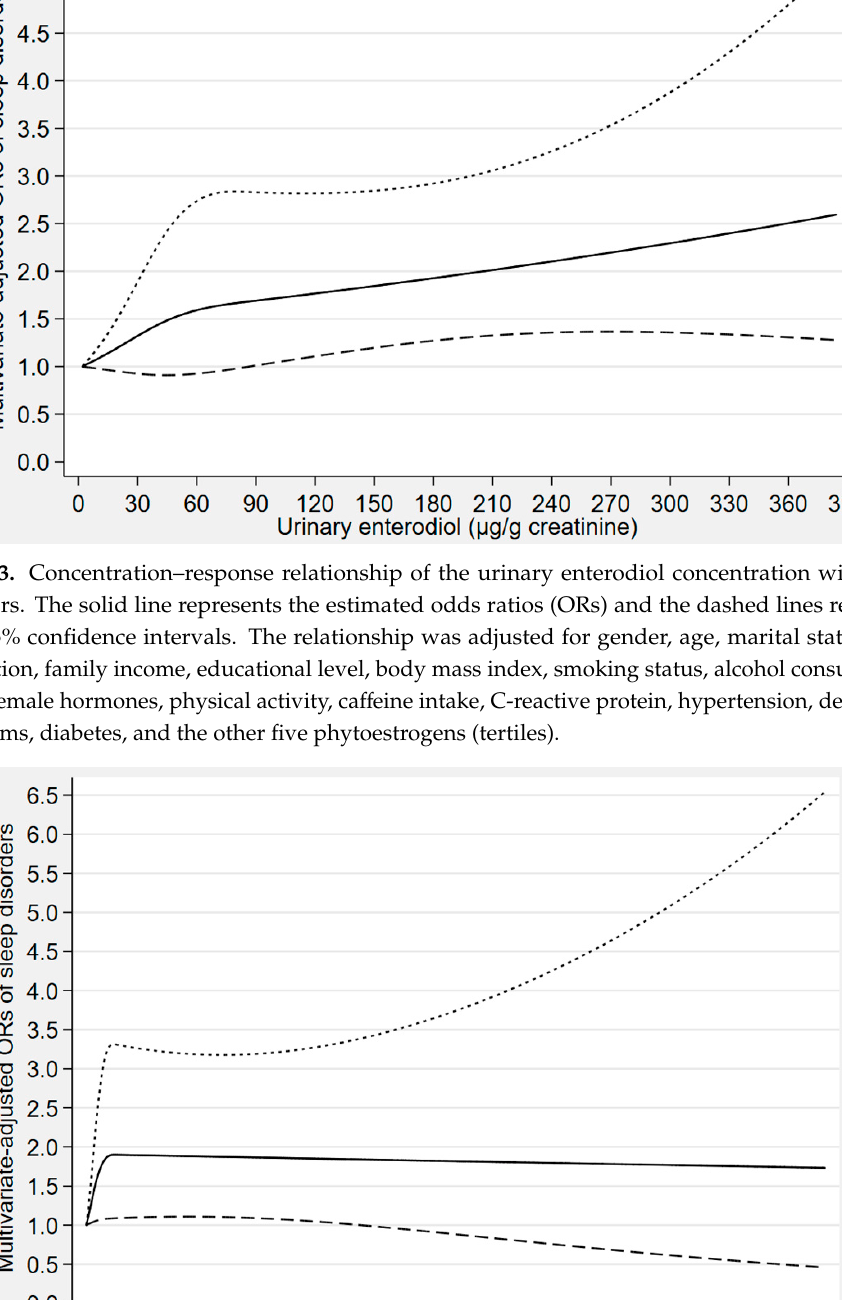
Figure 4. Concentration–response relationship of the urinary O-desmethylangolensin concentration with sleep disorders. The solid line represents the estimated odds ratios (ORs) and the dashed lines represent their 95% confidence intervals. The relationship was adjusted for gender, age, marital status, race, occupation, family income, educational level, body mass index, smoking status, alcohol consumption, use of female hormones, physical activity, caffeine intake, C-reactive protein, hypertension, depressive symptoms, diabetes, and the other five phytoestrogens (tertiles).